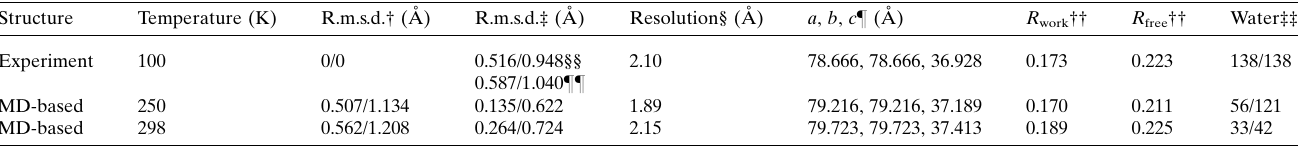
Table 1 Structure